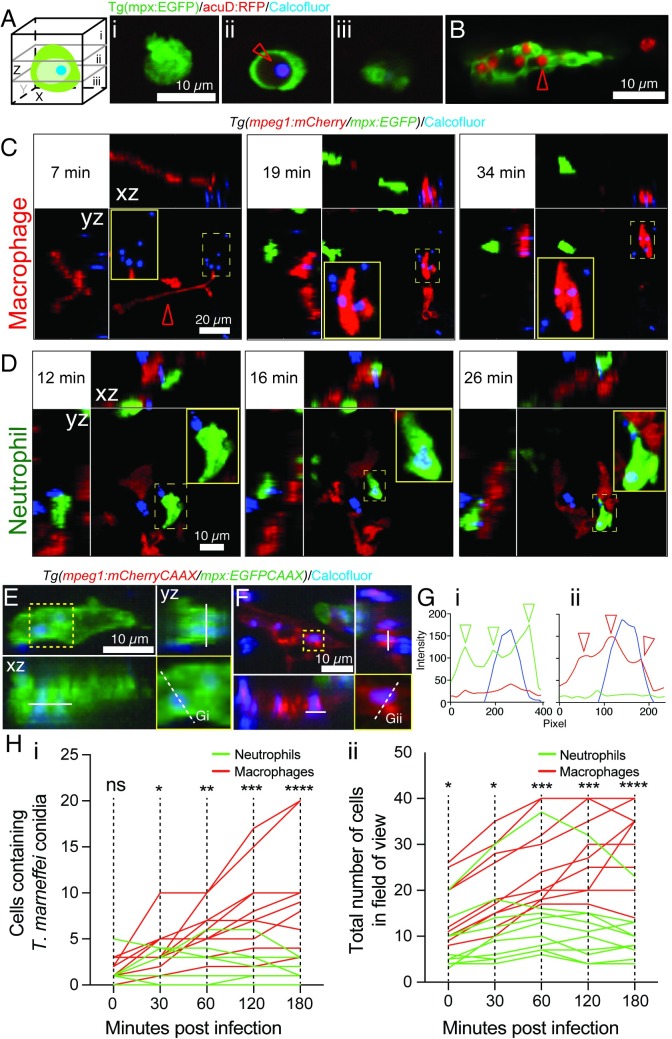
Macrophages dominate T. marneffei phagocytosis during infection establishment.(A, B) Confocal imaging of leukocytes and calcofluor-stained acuD:RFP fungal conidia in Tg(mpx:EGFP) fluorescent leukocytes. (A) shows a germinated, RFP-expressing, blue calcofluor-stained conidium (red arrow) within a non-fluorescent vacuole of a bright EGFPhigh neutrophil. Z-stack sections (i-iii) orientated as in schematic diagram. (B) shows a dull EGFPlow macrophage laden with multiple RFP-expressing conidia. (C,D) Phagocytosis of calcofluor-stained fungal conidia by a macrophage (C) and neutrophil (D) in Tg(mpeg1:mCherry/mpx:EGFP) embryo (C) inoculated in a somite. The still images are from S1 and S2 Movies respectively. The macrophage extends a long process towards the conidium (red arrowhead); conidial phagocytosis is followed by macrophage movement over the site of phagocytosis and out of the field. In each panel, maximum projection z-stack image is supplemented by xz and yz projections, orientated as in the schematic diagram. (E-G) Confocal imaging of intracellular calcofluor-stained conidia within a neutrophil (E) and macrophage (F) of a Tg(mpeg1:mCherryCAAX/mpx:EGFPCAAX) embryo, with dimensional projections as in (C). In each case, the lower right yellow-boxed panel is a detail of the yellow-boxed area in the upper left xy maximum intensity projection, displaying the cross-section (white dashed line) for which a fluorescence intensity channel profile is shown in G. Arrowheads indicate peaks of fluorescence corresponding to neutrophil (Gi, green) and macrophage (Gii, red) cellular membranes. (H) Enumeration of conidia phagocytosis (i) by macrophages (red lines) and neutrophils (green lines) reflects higher macrophage recruitment (ii) following somite infection. Lines represent individual infected zebrafish followed over time. N = 10 embryos/group imaged on n = 8 different days. P-values from Mann-Whitney test: ns = not significant, * = <0.05, ** = <0.01, *** = <0.001, **** = <0.0001.